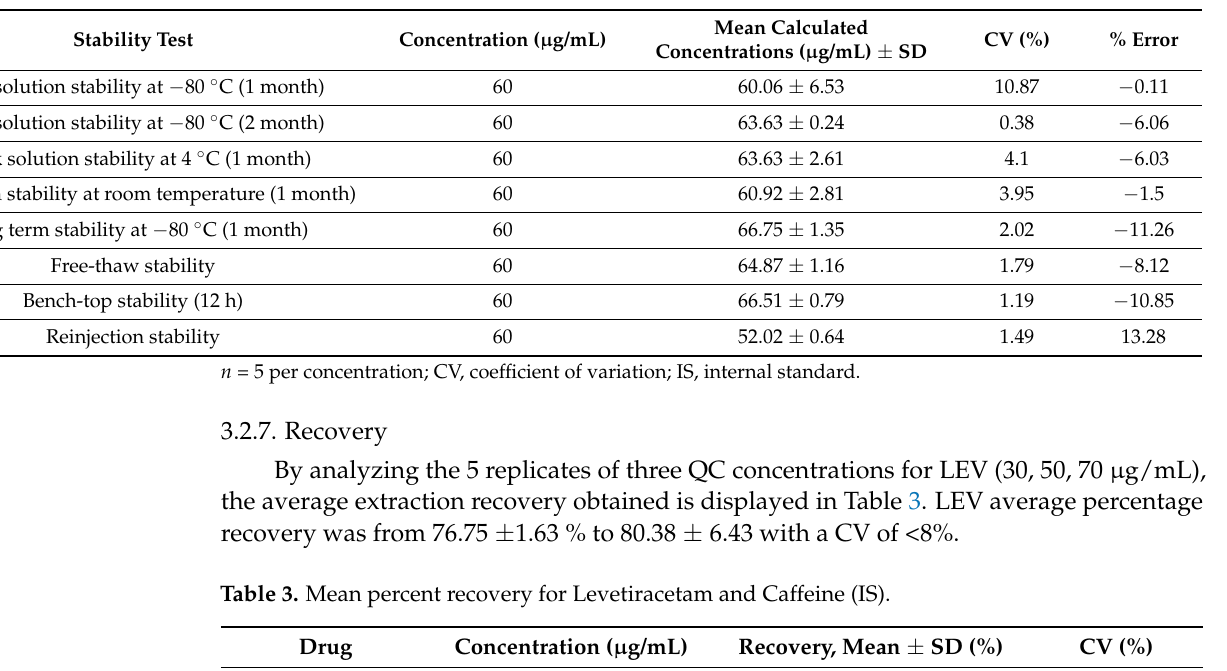
Table 2. Levetiracetam stability testing.